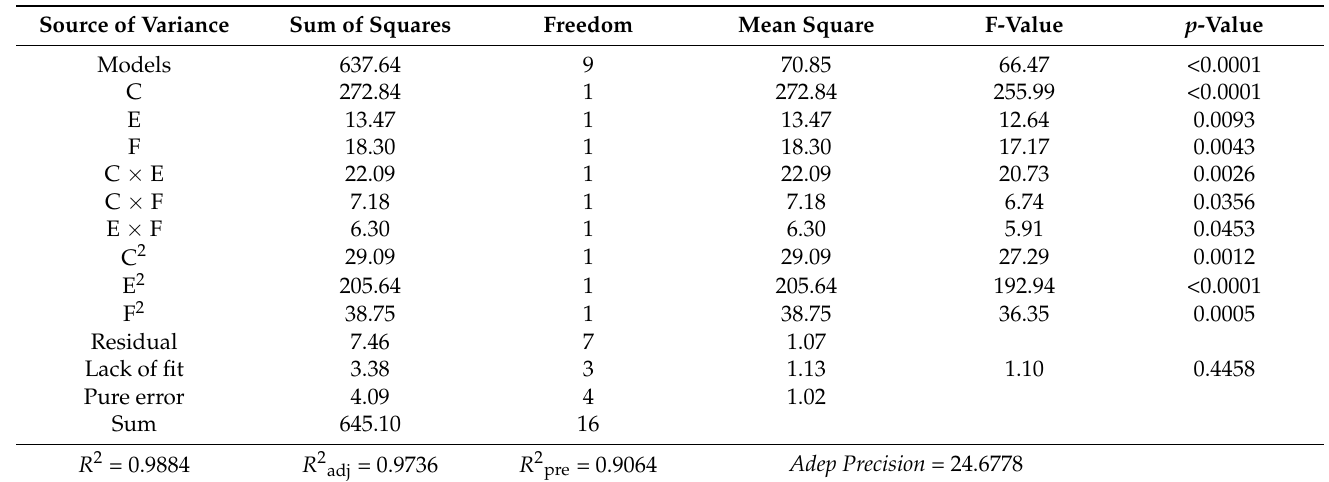
Table 5. Box-Behnken experimental model